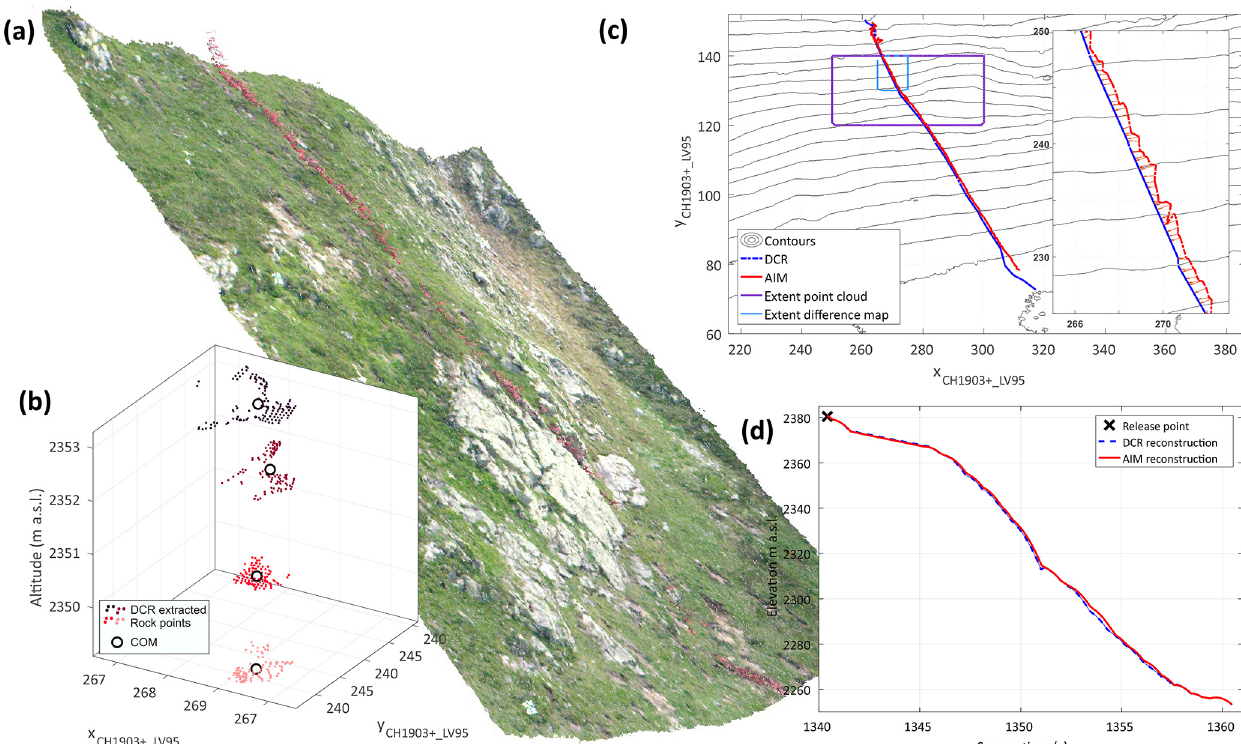
Figure 4. Photogrammetric workflow for the dense cloud reconstruction method. Inset (a) depicts a visualization of superimposed recon- structed point clouds of one upper trajectory sector. The pink rock is distinguishable well in most of the image pairs. Panel (b) shows the centre of mass extraction (o) for matched points clouds after colour-filtered extraction of the rock at four subsequent positions. Panel (c) shows ( xy ) planar top view of the reconstructed trajectories of RF18 Run 1 from both the DCR and AIM (violet frame – outline of (a) ; blue frame – outline of inset within (c) ). Panel (d) displays the comparison of reconstructed flight parabolas from AIM with fitted parabolas from DCR, showing the z view